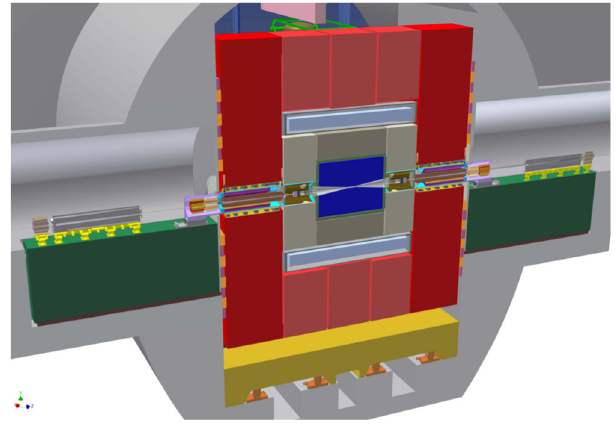
FIG. 1. Vertical cut through the SiD experiment. QD0 is located inside the detector and partially supported by the preinsulator (green block) in the tunnel